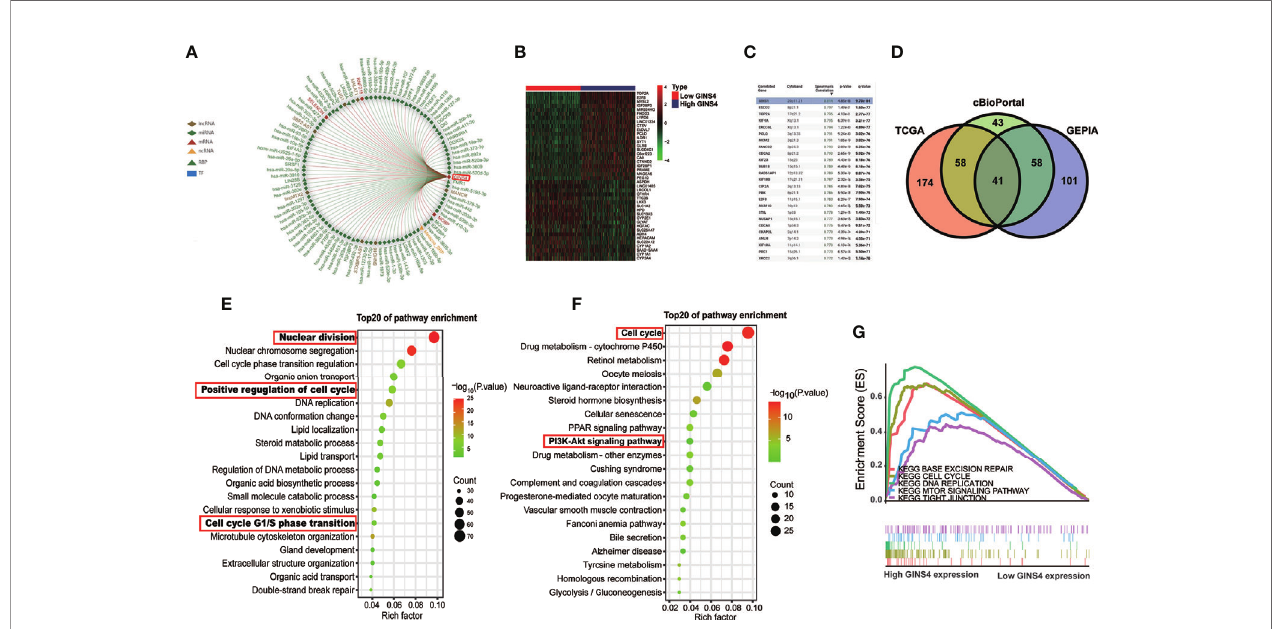
FIGURE 12 | High GINS4 expression positively modulates the cell cycle pathway in HCC development. (A) RAID database revealed certain miRNAs, lncRNAs, RBPs, TFs interacting with GINS4. (B) Heatmap of the DEGs co-expressed with GINS4 in HCC samples ( │ log 2 FC │ > 2). (C) The top 25 genes associated with GINS4 transcript level in HCC based on the cBioPortal database. (D) Venn diagram illustrated the intersection of genes co-expressed with GINS4 in HCC among the TCGA, the cBioPortal, and the GEPIA database. The top 20 signaling pathways in HCC via (E) GO and (F) KEGG analysis. (G) GSEA of the whole DEGs co- expressed with GINS4 in HCC. DEGs, differently expressed genes; TF, transcription factors; NES, normalized enrichment score; RBP, RNA-binding